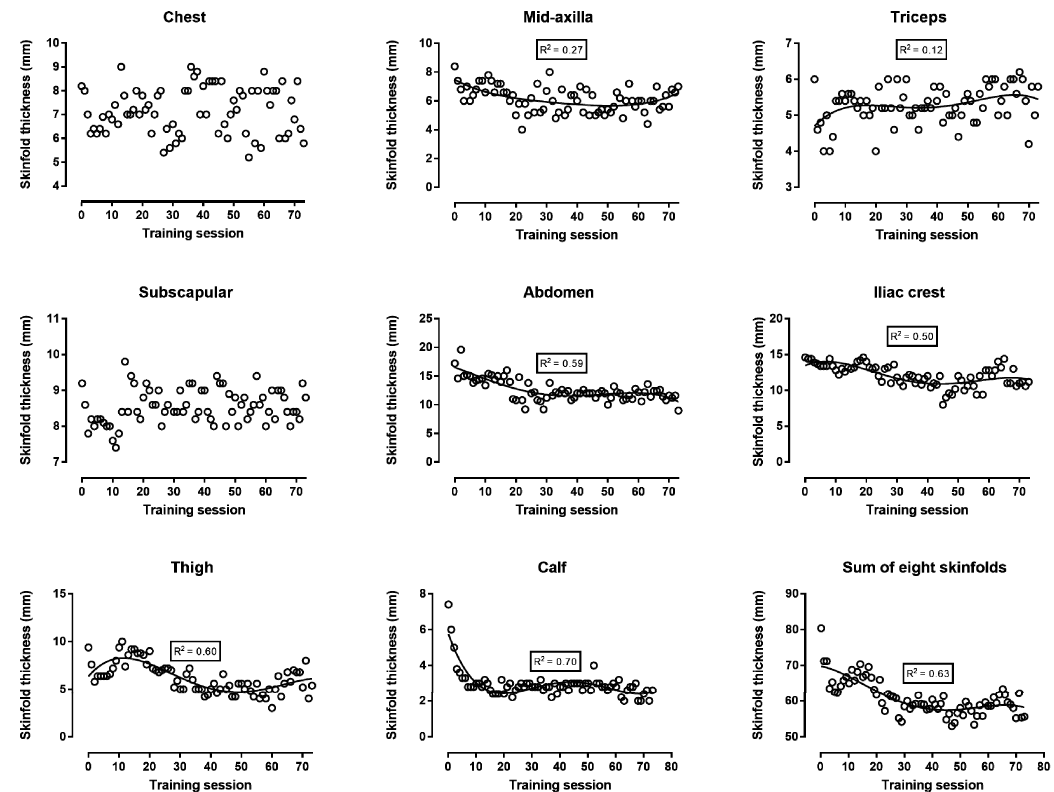
Figure 5. Skinfold thickness in absolute values during the preparation for a 48-hour ultra-marathon run.